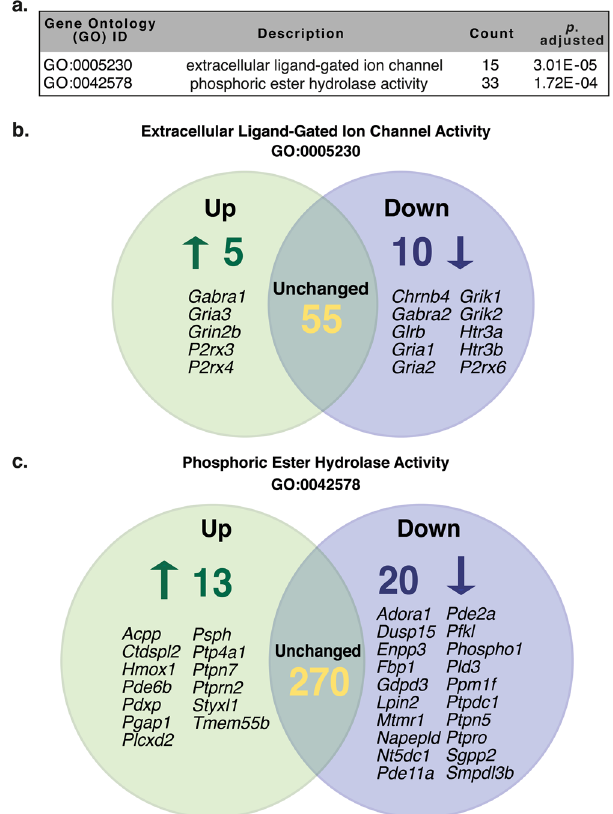
Figure 3. Gene Ontology: Molecular Function Category. The top two over-represented molecular function (MF) gene ontology (GO) groups include ‘extracellular ligand-gated ion channel activity’ (GO:0005230) and ‘phosphoric ester hydrolase activity’ (GO:0042578; a ). Venn diagrams depict the upregulated genes (green) and downregulated genes (blue) in each GO group ( b , c ; respectively). All other over-represented GO groups are included in the supplementary